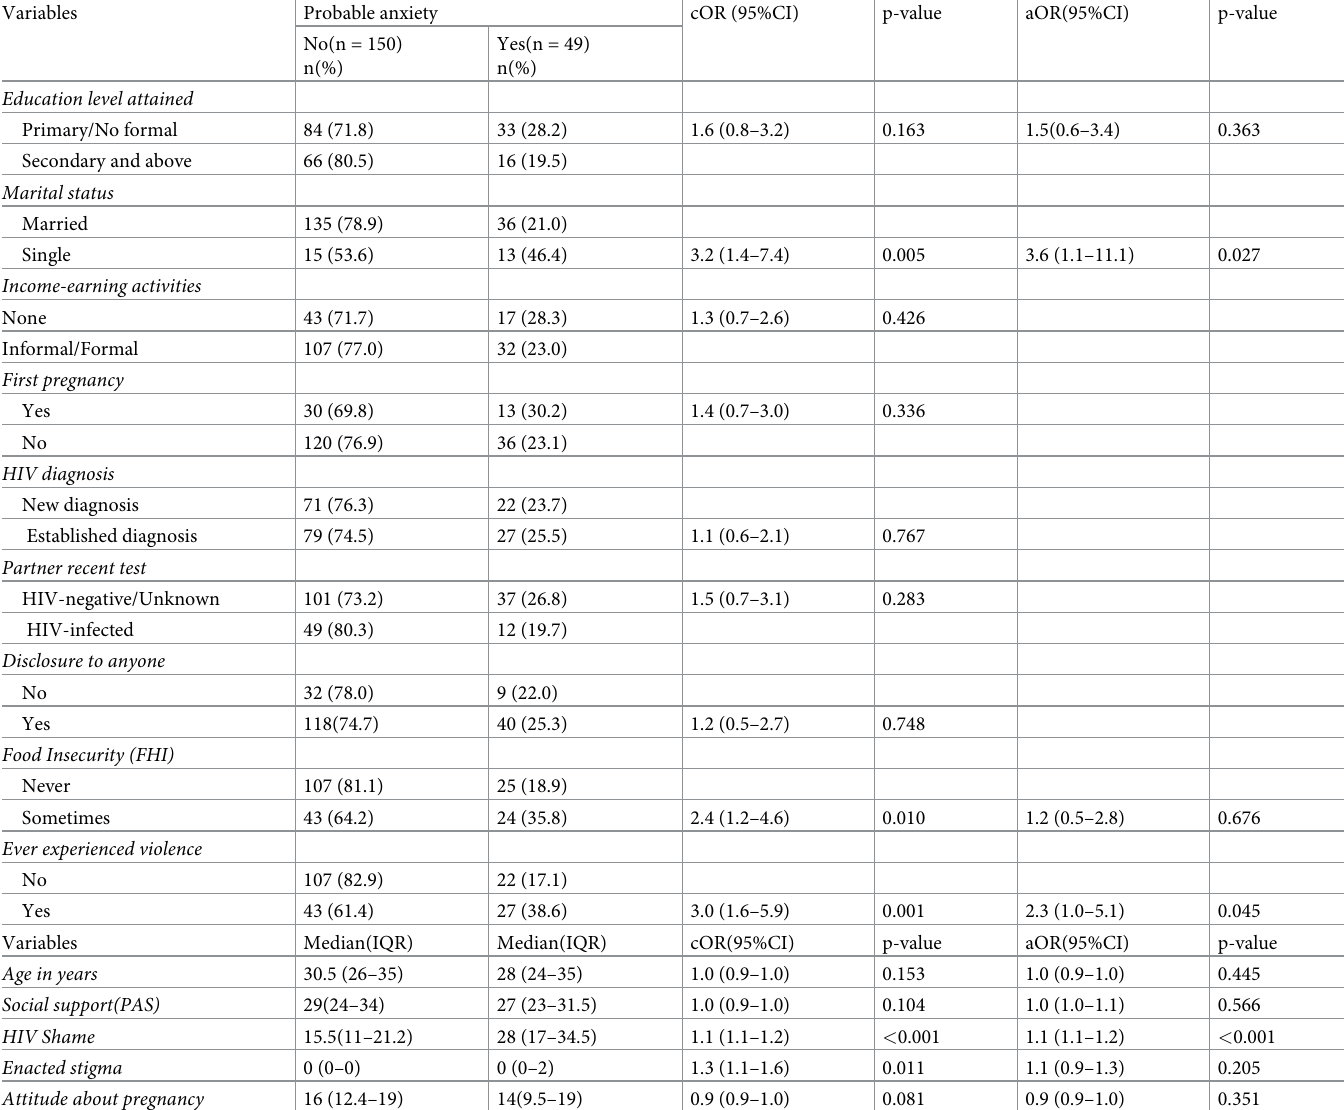
Table 3. Bivariate and multivariate analysis of factors associated with probable anxiety among pregnant women living with HIV (n =